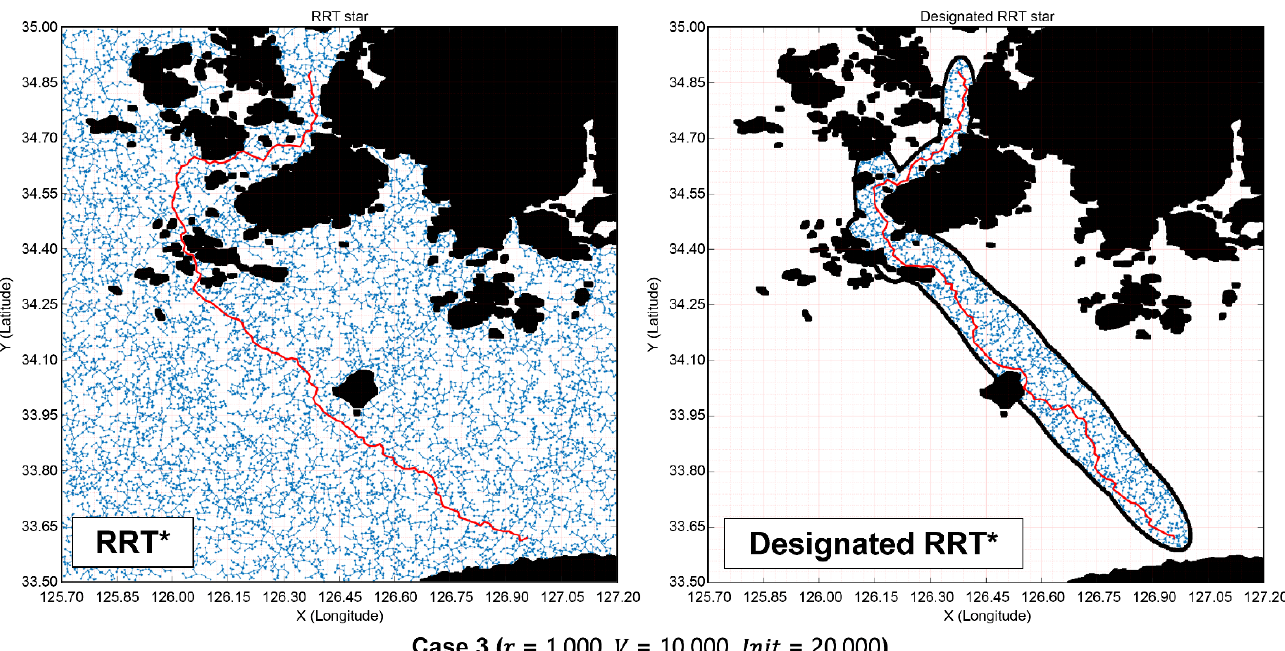
Figure 23. Comparison of the simulation results (Case 3).